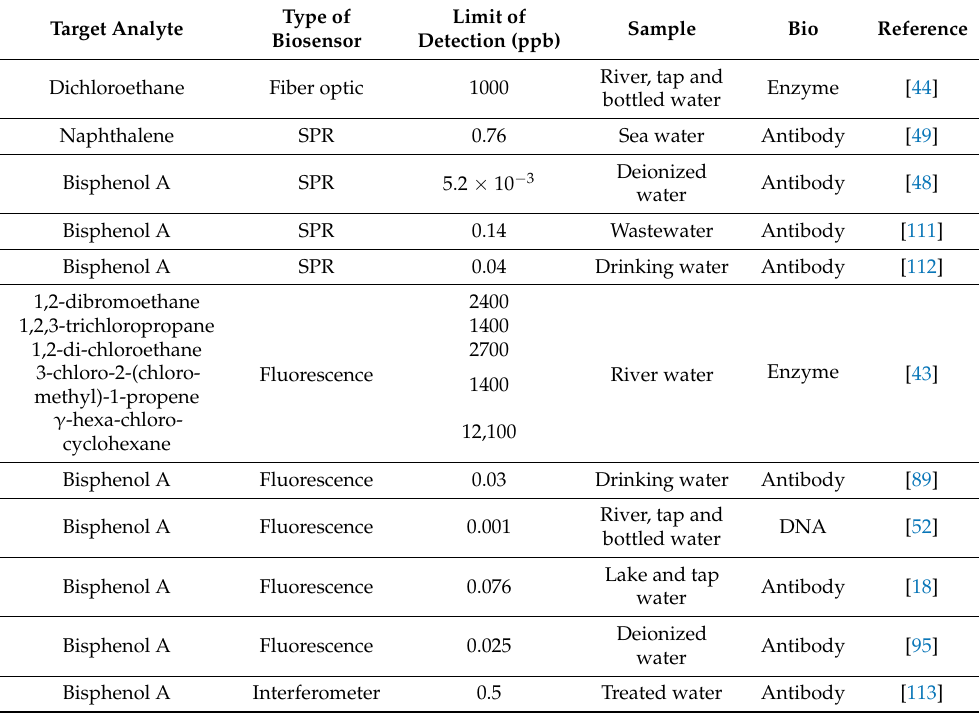
Table 4. Published work on detection of organic compounds in